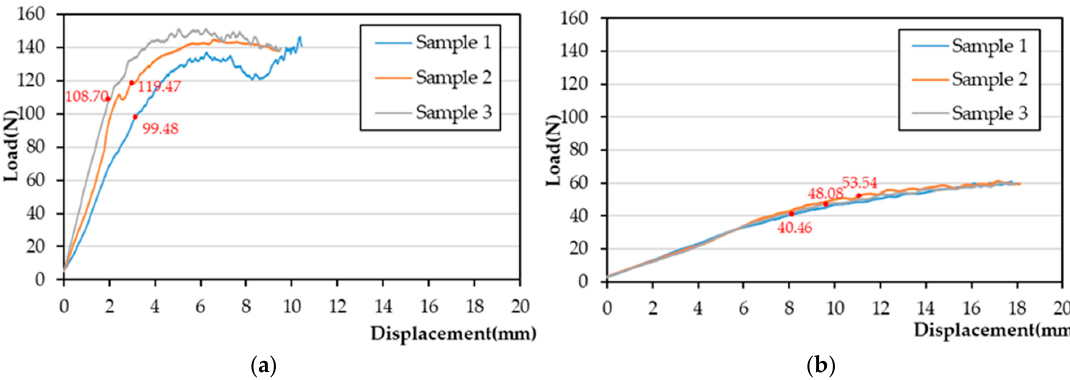
Figure 4. Static four-point bending test load displacement diagrams for HDDP and DDP. The red dots indicate the proof load ( a ) for HDDP and ( b ) for DDP.